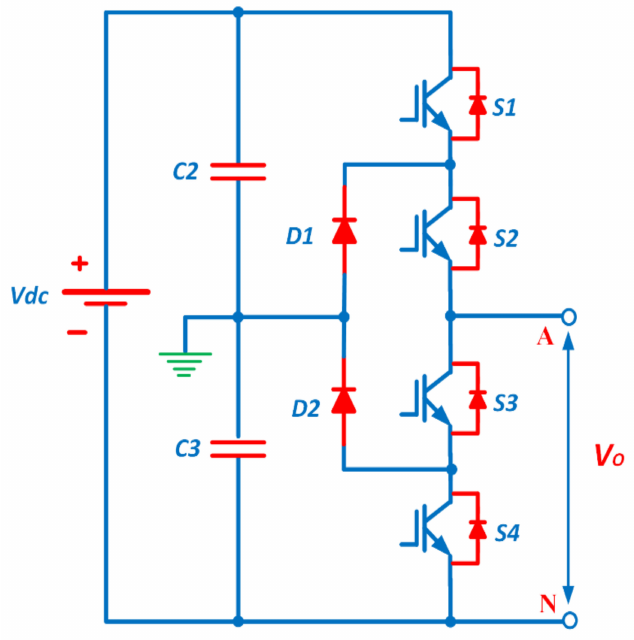
Figure 5. Three-level diode-clamped MLI